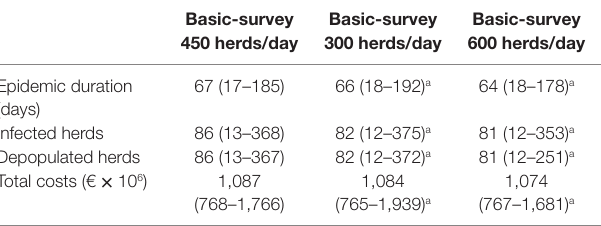
TaBle 2 | sensitivity analysis on resources for clinical surveillance.